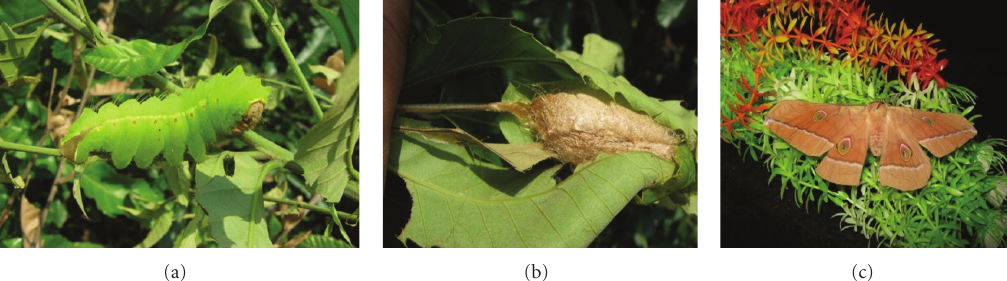
Figure 1: The native oak tasar silkworm of Manipur, North-East India, Antheraea proylei (a) larva, (b) pupa, and (c) adult moth.